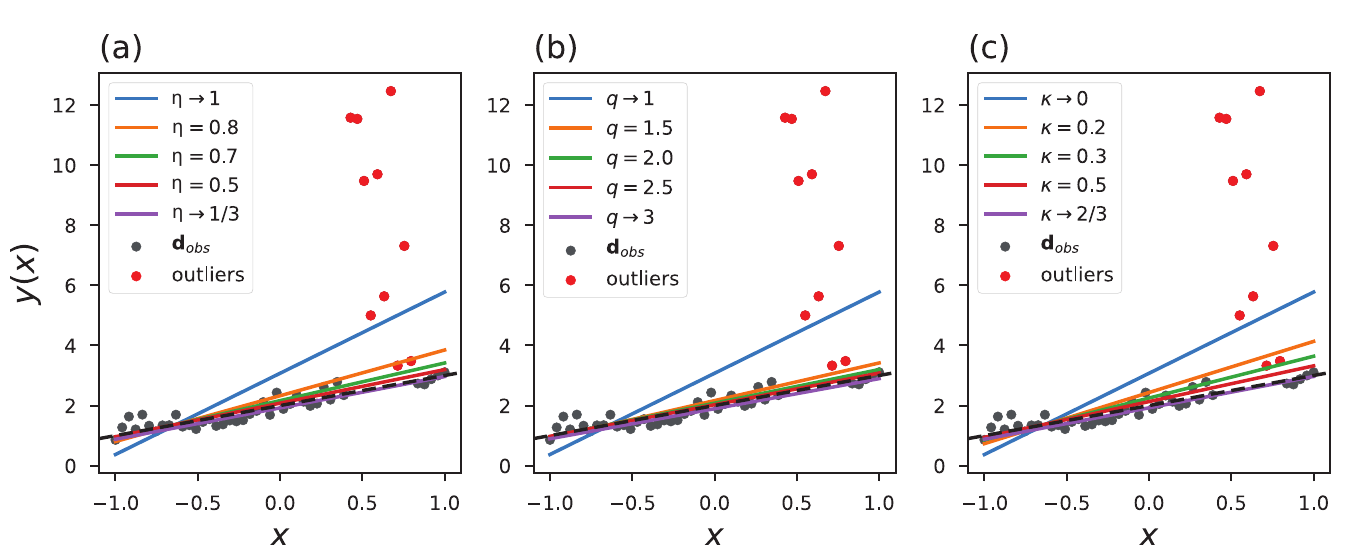
Fig 8. Fit of the estimated lines using the objective functions of (a) Re´nyi, (b) Tsallis and (c) Kaniadakis. The dashed line indicates an ideal line, and the points highlighted in red indicate the inserted outliers.